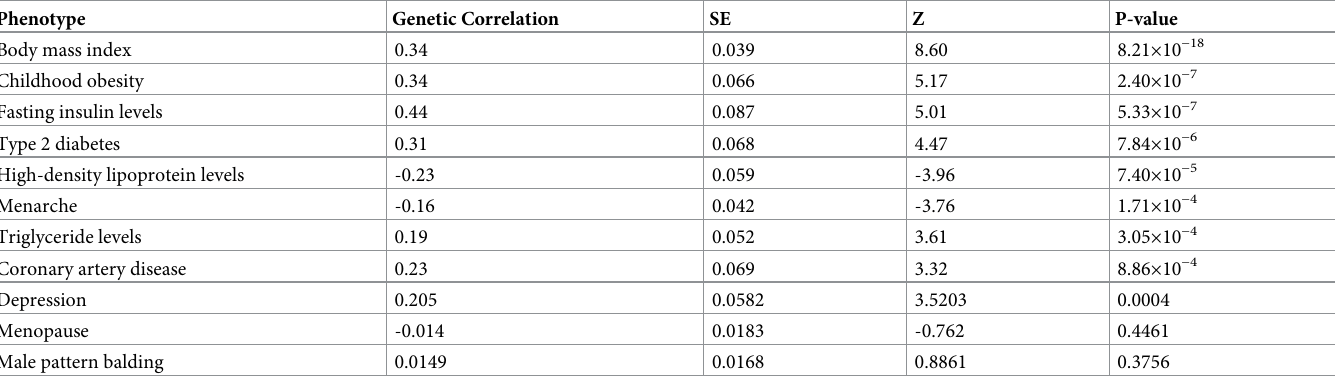
Table 4. LD Score regression results using the LDSC